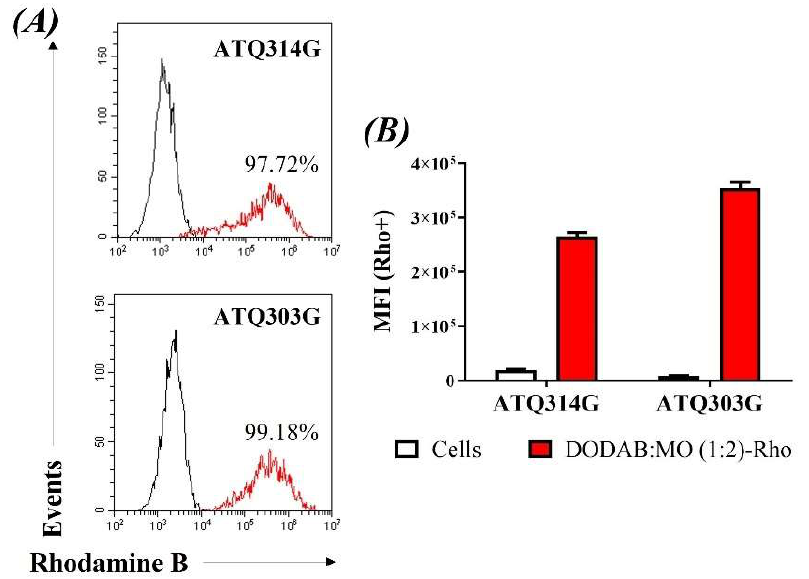
Figure 3. Cellular internalization of rhodamine labelled liposomes by the ATQ314G and ATQ303G cell lines after 5 h of incubation. ( A ) histograms or ( B ) median fluorescence intensity (MFI).